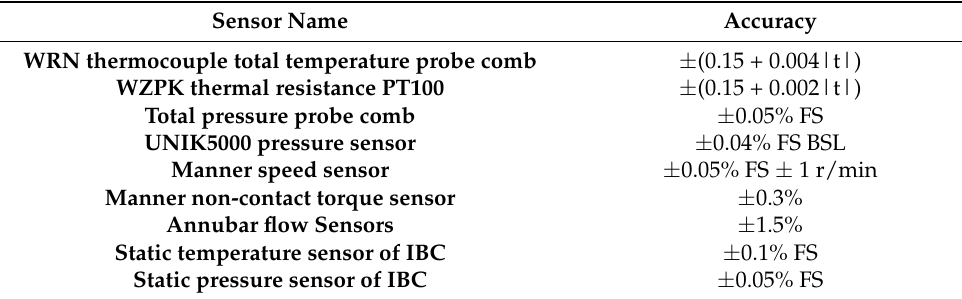
Table 5. The accuracy of